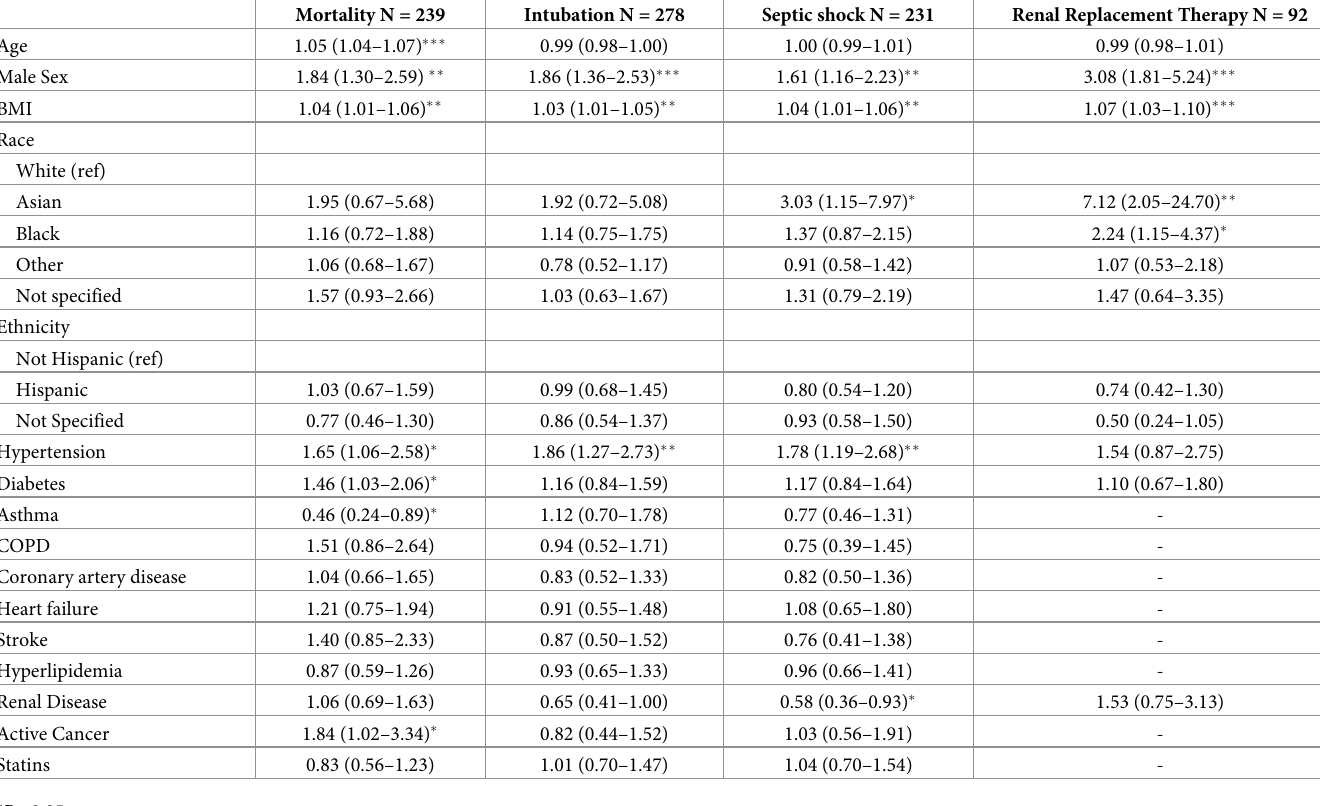
Table 3. Multivariable regression analysis of BMI and endpoints of